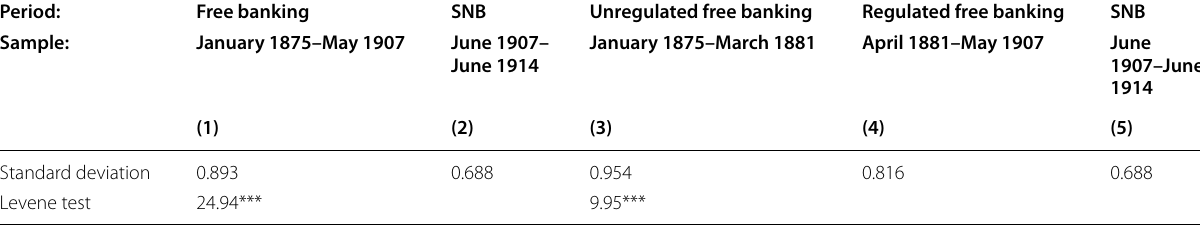
Table 4 Analysis of variance (ANOVA) of the discount-rate in Switzerland (1857–1914)